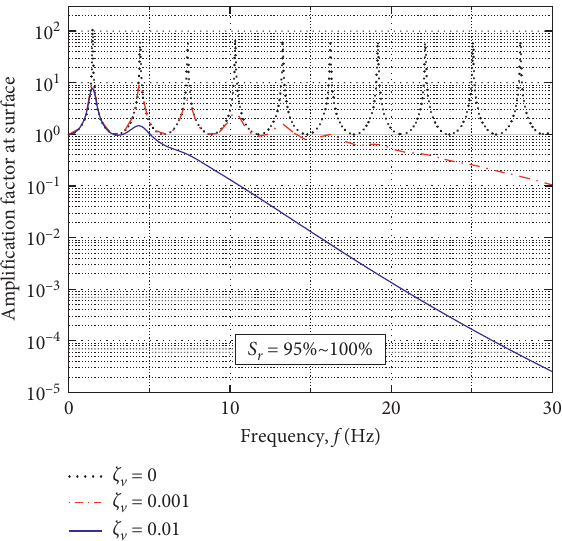
Figure 9: Variation of amplification factor at surface with frequency (horizontal